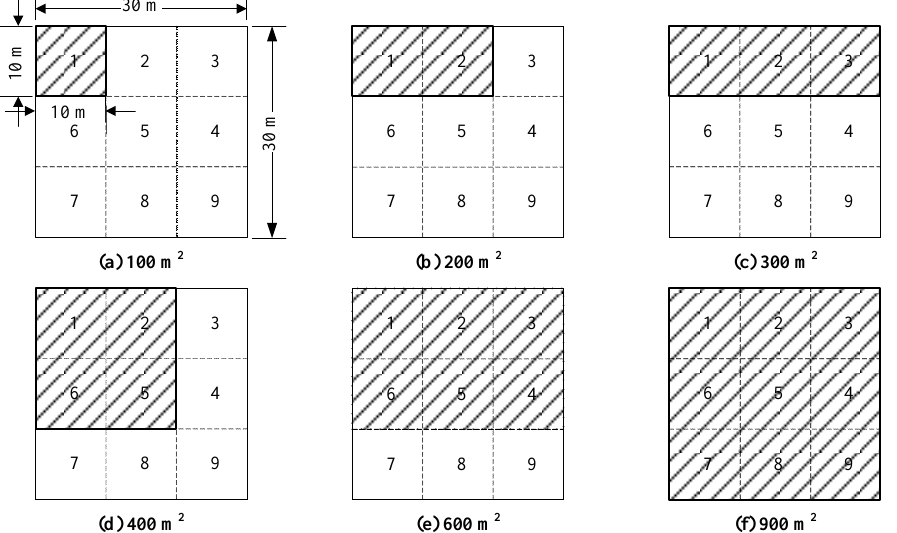
Table 1. Summary of field measurements of the 900 m 2 field plots. CV is the coefficient of variation.